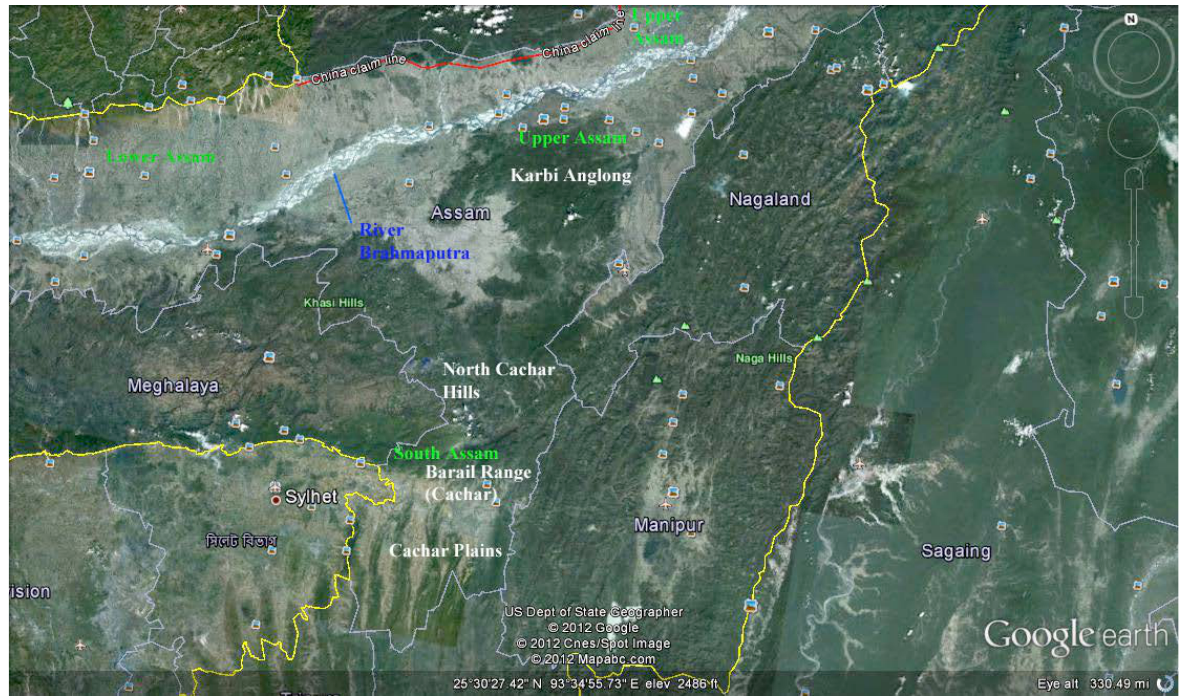
Figure 1. Map showing Upper Assam and South Assam